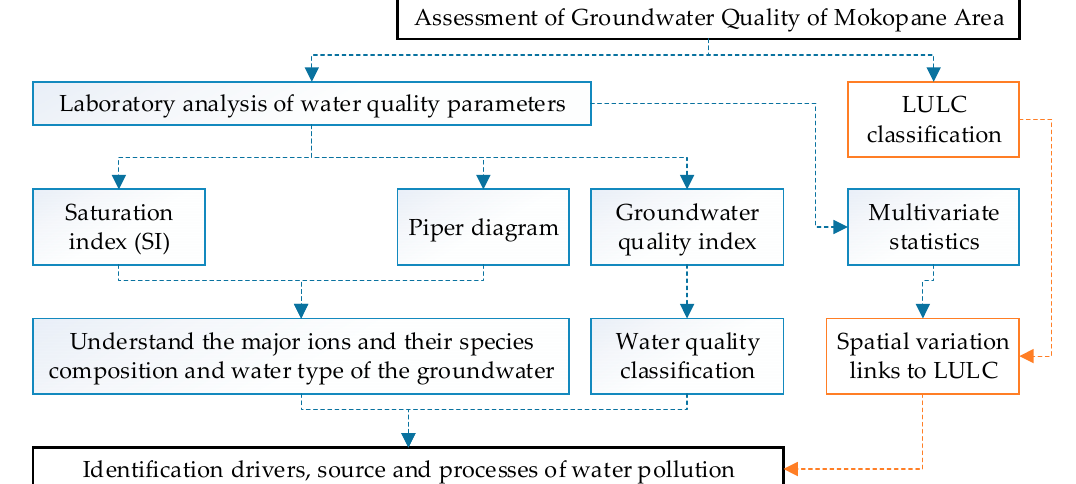
Figure 4. Flowchart of the methodology employed in this study for the assessment of groundwater